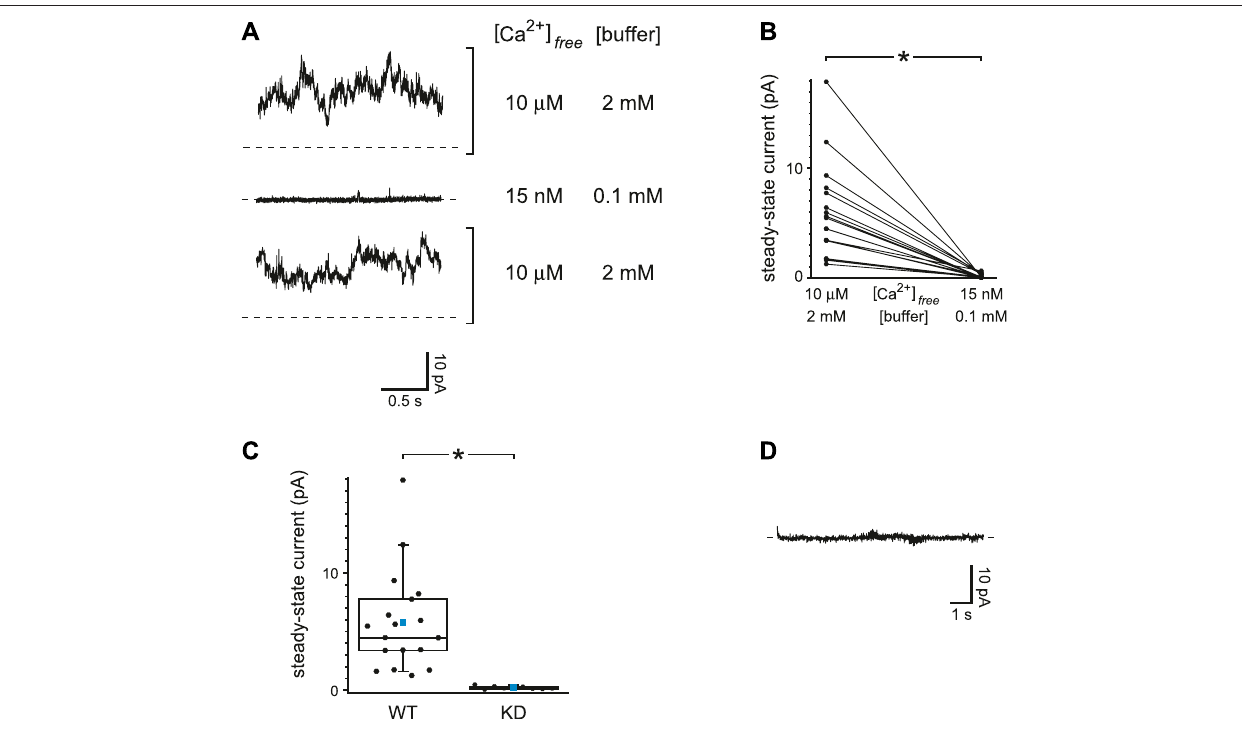
FIGURE6| TRPM4currentisinsensitivetoCa 2+ buffering. (A) Steady-stateactivitywasmeasuredat+60 mVineachoftwointernalsolutions.The fi rstofthese(top and bottom recordings) had 10 µM free Ca 2+ buffered with 2 mM dibromoBAPTA. The other solution had 15 nM free Ca 2+ buffered with 0.1 mM BAPTA. (B) Paired mean steady-state currents at +60 mV for 18 cilia, each tested in each of the two internal solutions. * p < 0.001. (C) Mean steady-state currents at +60 mV in 10 µM free Ca 2+ buffered with2 mMdibromoBAPTAinciliafromwild-type cells(WT, n =18cilia)orcellsinwhichTRPM4wasknockeddownwithshRNA(KD, n =8cilia). The valuesforwild-type cellsaretakenfrom Figure6B .* p < 0.001. (D) AbsenceoftransientactivationofTRPM4intheinternalsolutioncontaining15 nM freeCa 2+ buffered with0.1 mMBAPTA.Thecurrentshownwasmeasuredat+60 mVimmediatelyfollowingaprepulseof10 sto − 140 mV.RecordingsinpartsAandDarefromthesame